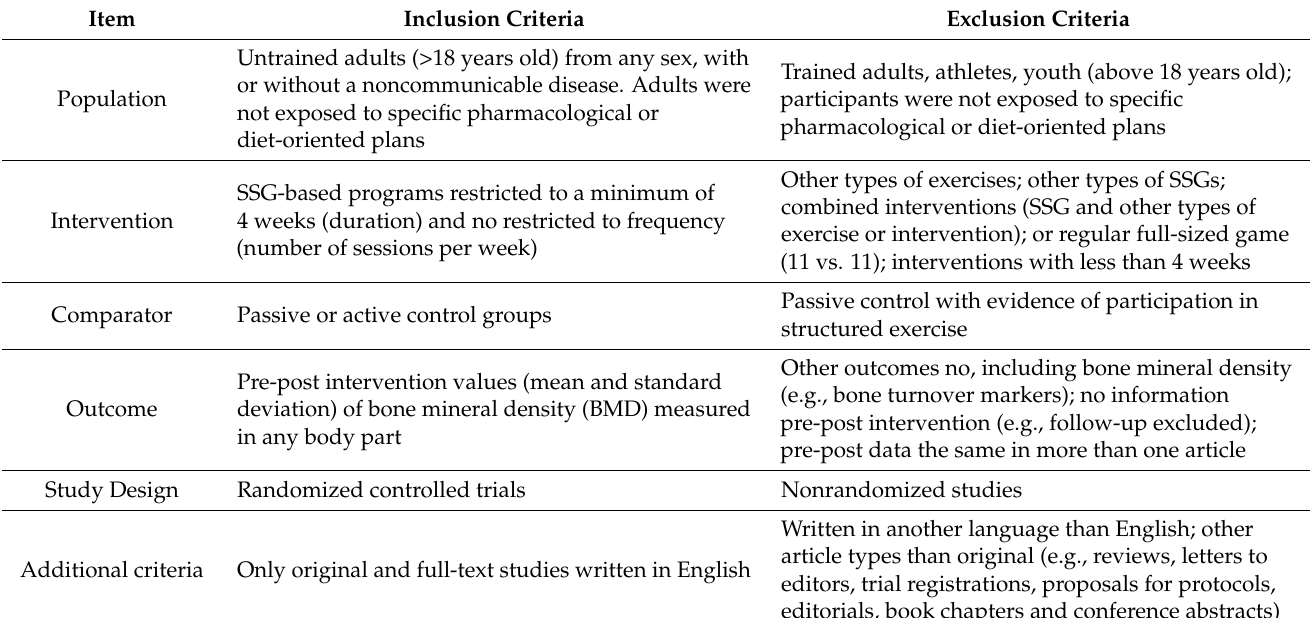
Table 1. Inclusion and exclusion